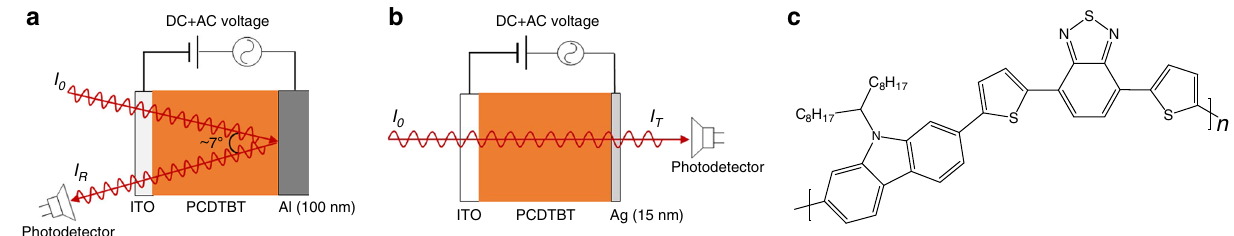
Fig. 1 Schematics of the device structure and optical path. a Re fl ection (R) mode electromodulation (EM) con fi guration. b Transmission (T) mode EM con fi guration. I 0 is the incident light intensity; I R and I T correspond to the light intensity after passing through the device for R mode and T mode, respectively. c Molecular structure